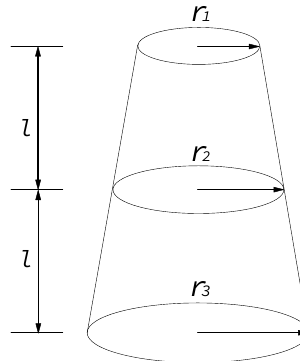
Figure 4. Simplified model of a CFN.